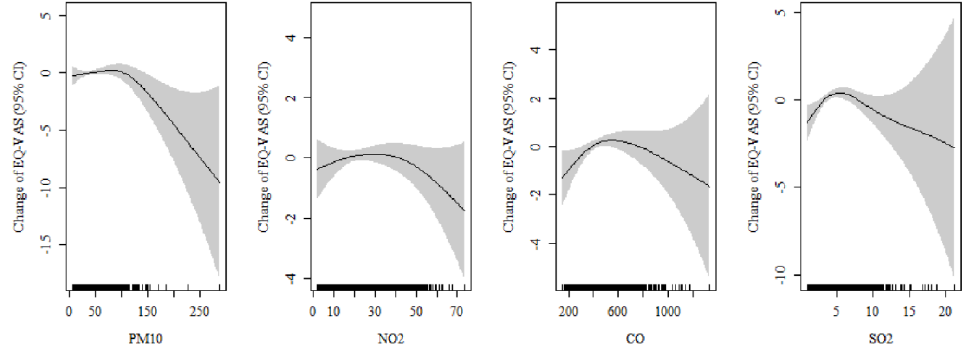
Figure 1. Change in the EQ-VAS scores per unit increment of air pollutants in subject with chronic